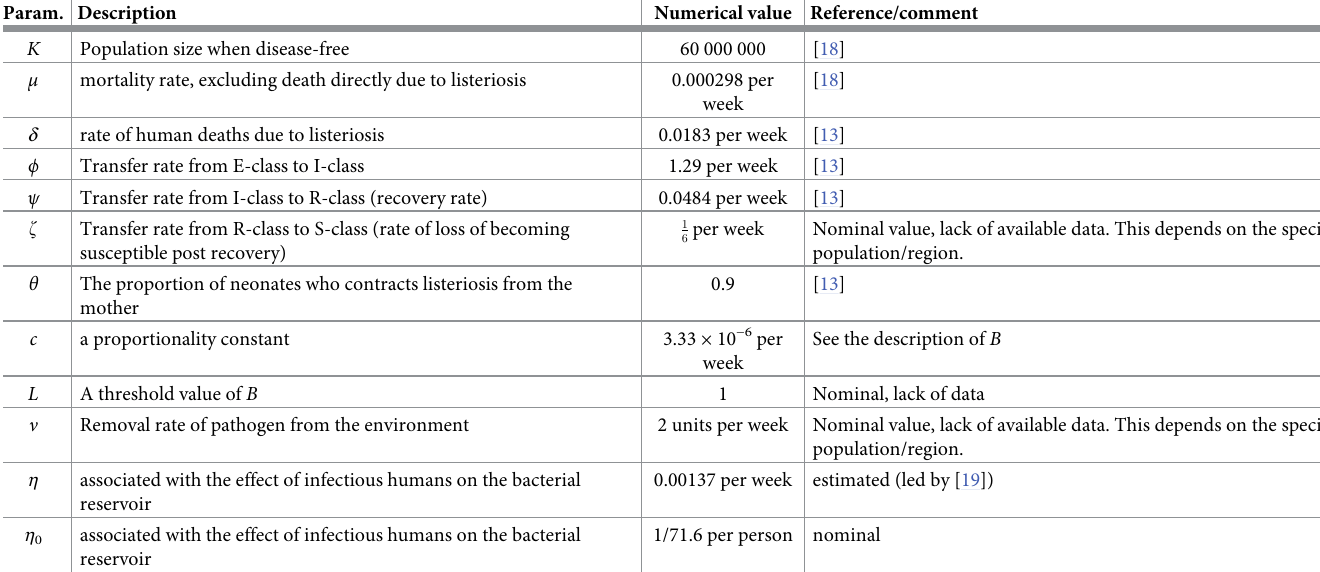
Table 1. Numerical values of parameters. Param.